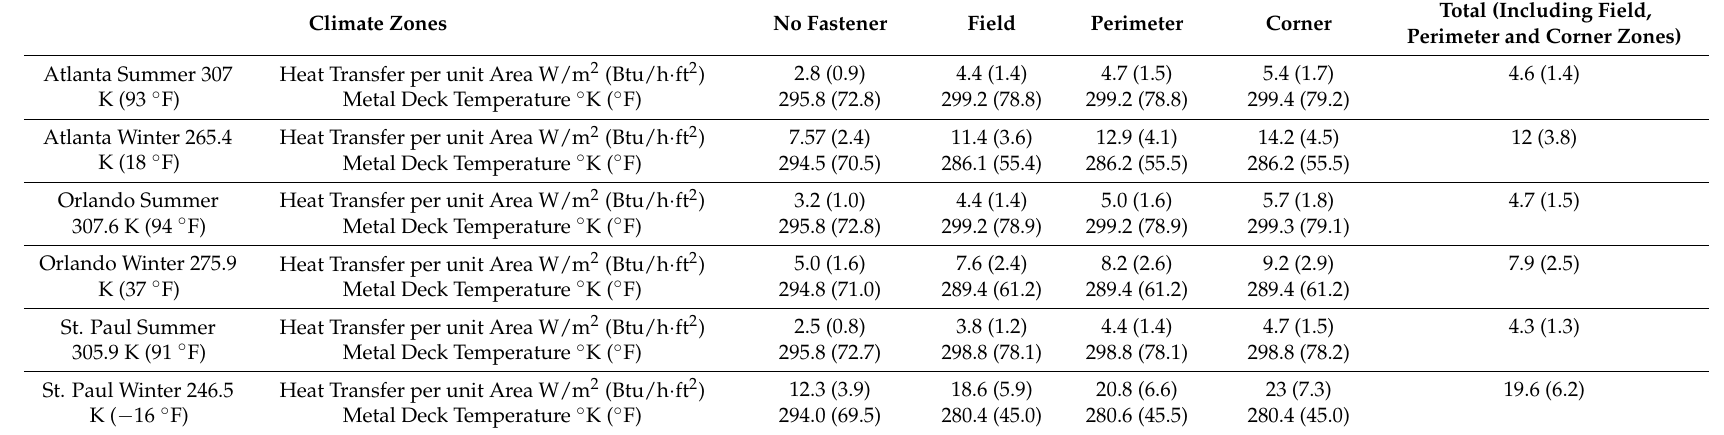
Table 5. Heat transfer per unit area and the metal deck temperatures for the three Climatic Zones in case of Assembly